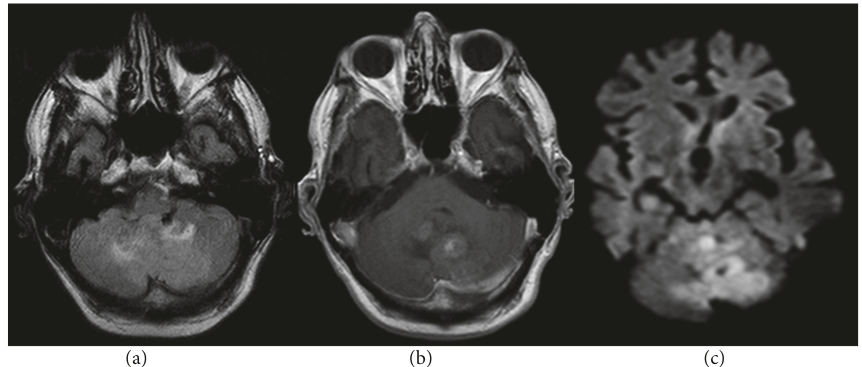
Figure 1: Transversal 1.5 Tesla FLAIR images (a) of a left cerebellar and vermal medulloblastoma show poor tumor delineation and inhomogeneoushyperintensity.MedulloblastomasnormallyappearhypointenserelativetograymatteronT1wimageswithminimaltopatchy contrast enhancement (b) and moderate restriction on diffusion weighted images (c).